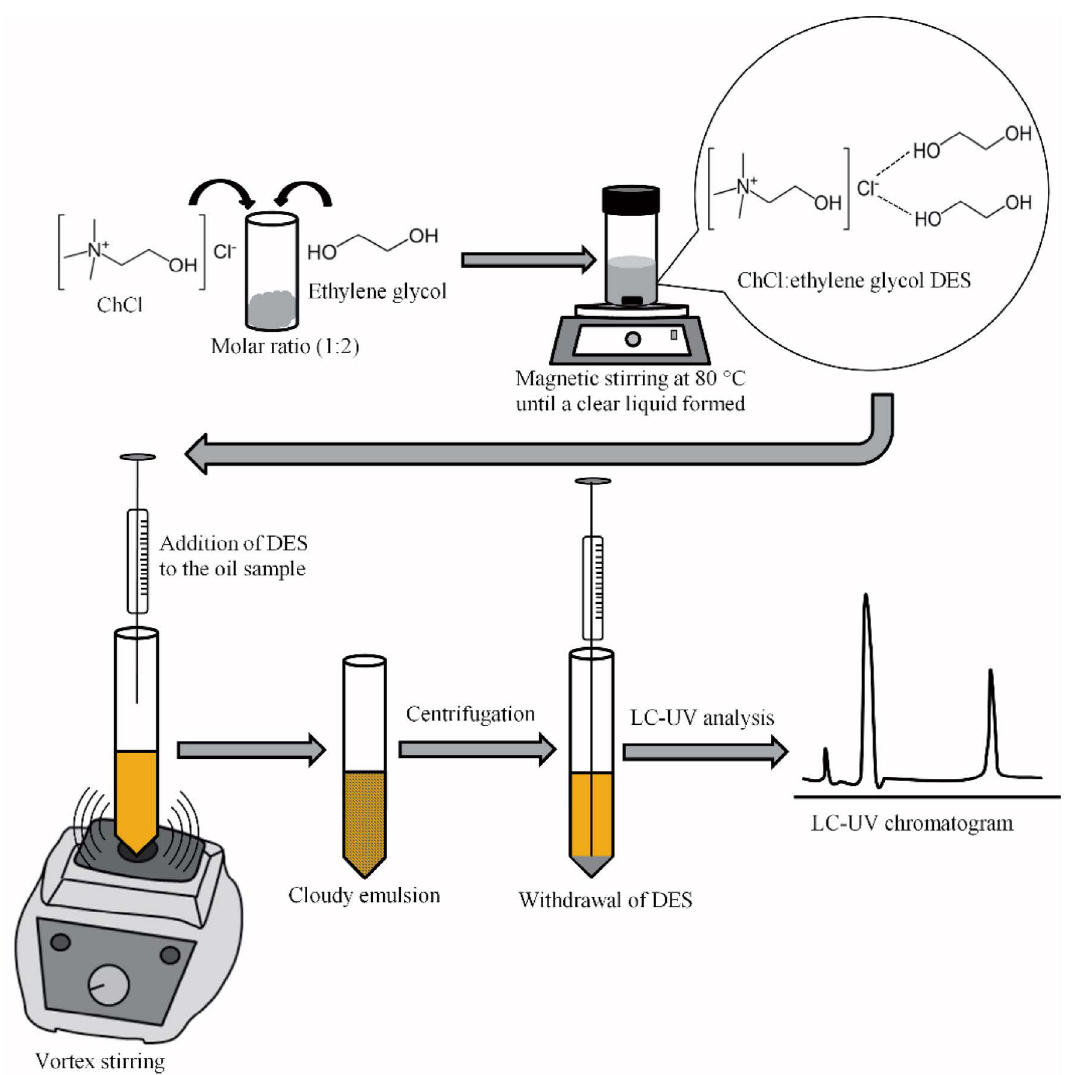
Figure 1. Schematic diagram of the preparation of ChCl:ethylene glycol DES and VA-DES- LLME